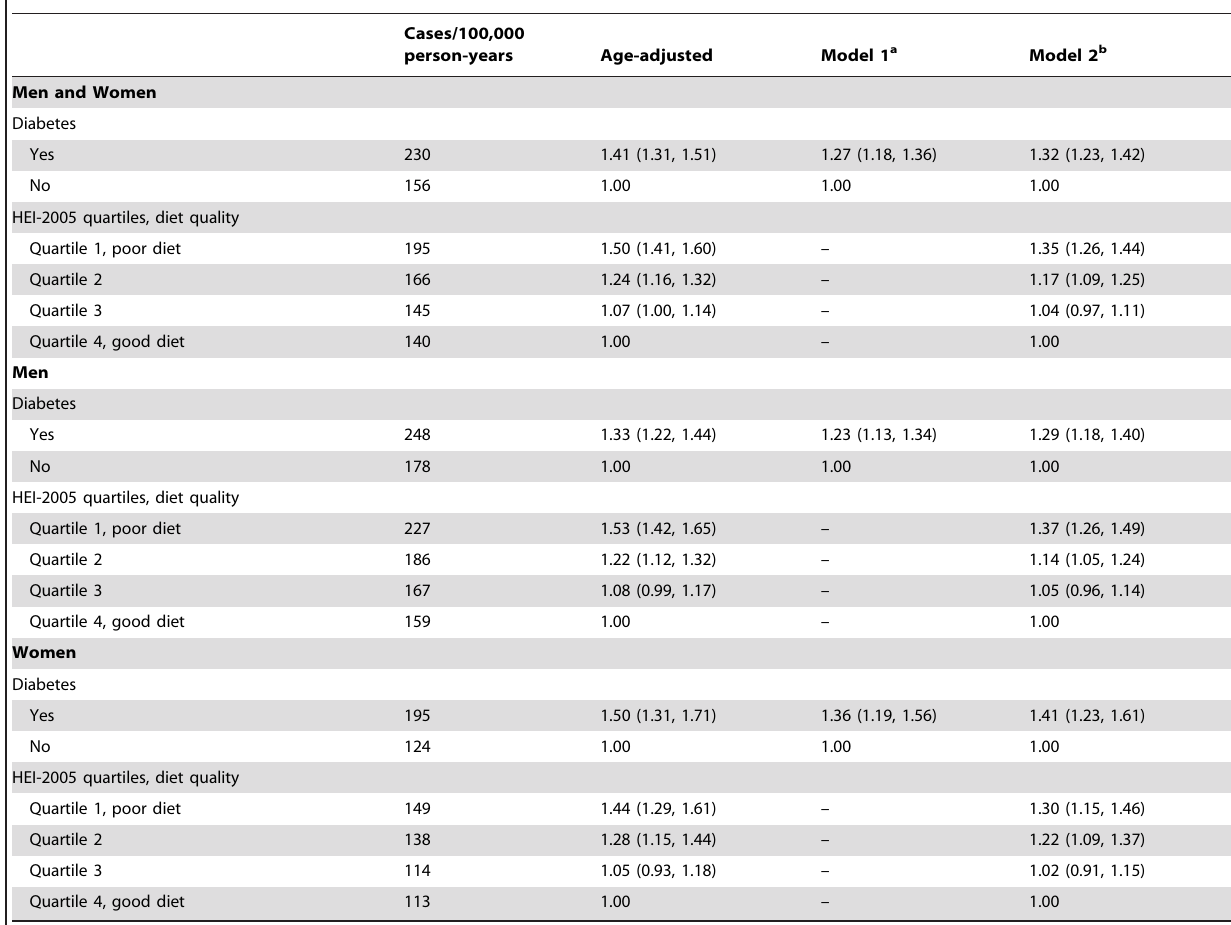
Table 2. Diabetes, Diet Quality and Risk of Colorectal